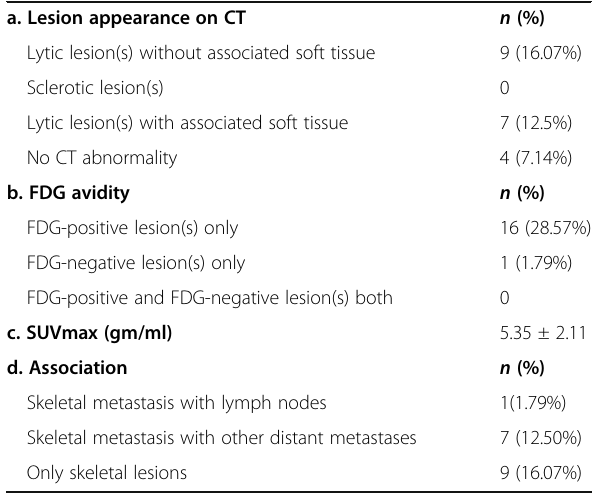
Table 9 Characteristics of skeletal metastatic lesions, n =